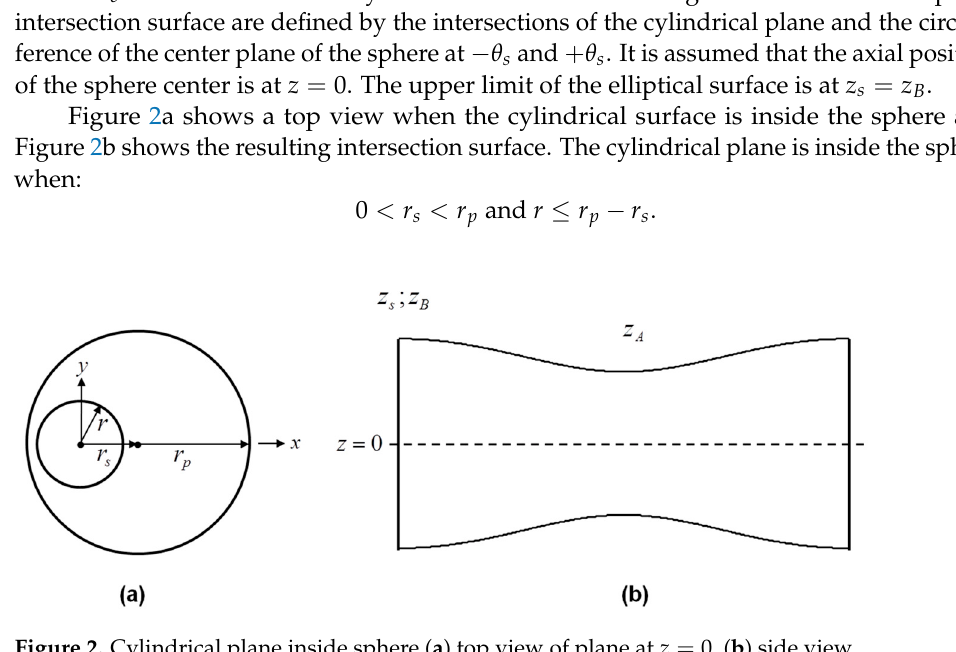
Figure 2. Cylindrical plane inside sphere ( a ) top view of plane at 0 z = , ( b ) side view.